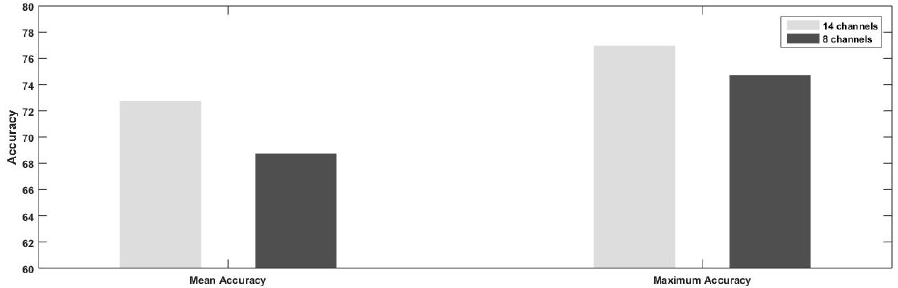
Figure 8. Comparison of mean and maximum classification accuracies achieved from subject-specific configuration of 8 and 14 electrodes, respectively.